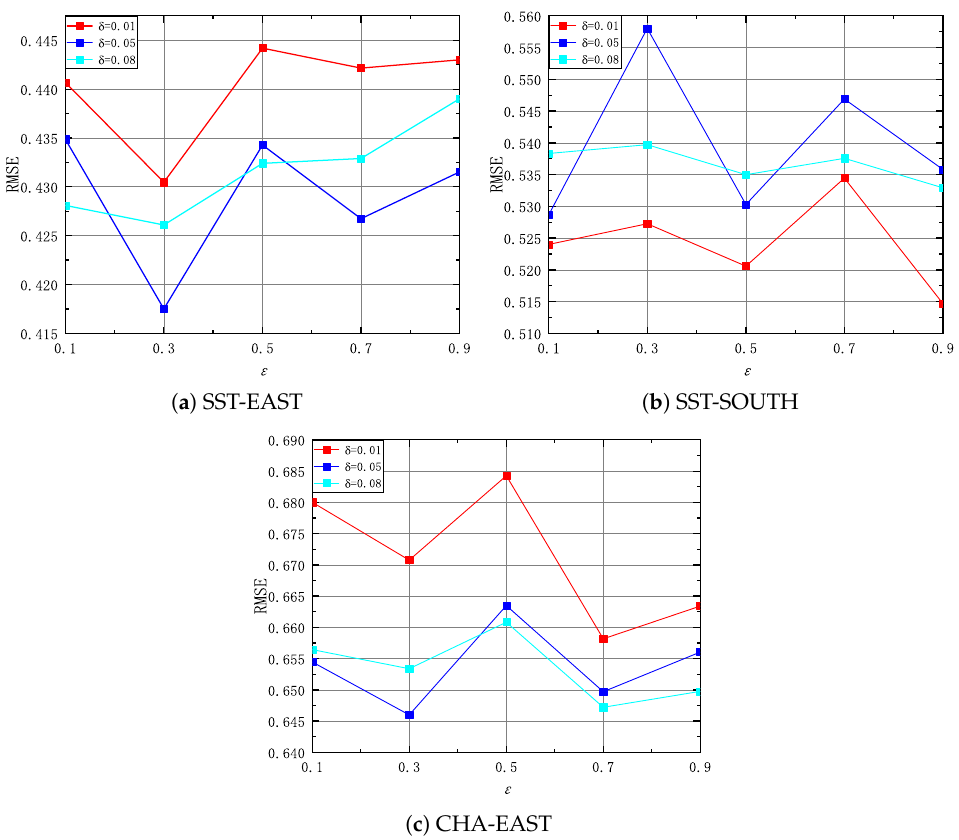
Figure 10. The RMSE of STA-GAN model while varying ε and δ , where the missing rate is 0.5.